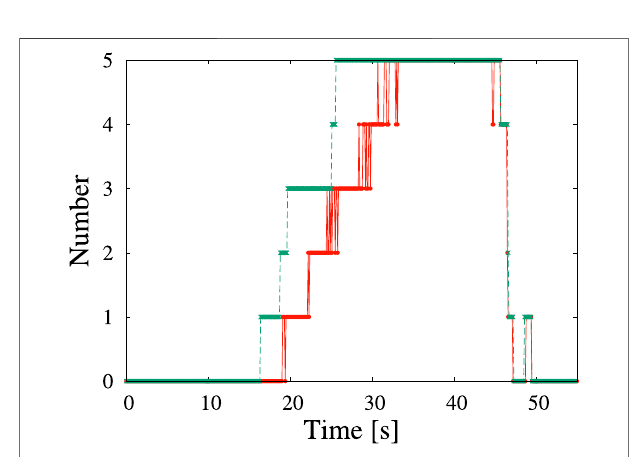
FIGURE 2 | Time change of the number of particles corresponding to Figure 1 detected by machine learning (red solid line) and by the human eye (greenbrokenline).Theoriginoftimecorrespondstowhentheviewwas fi xed.